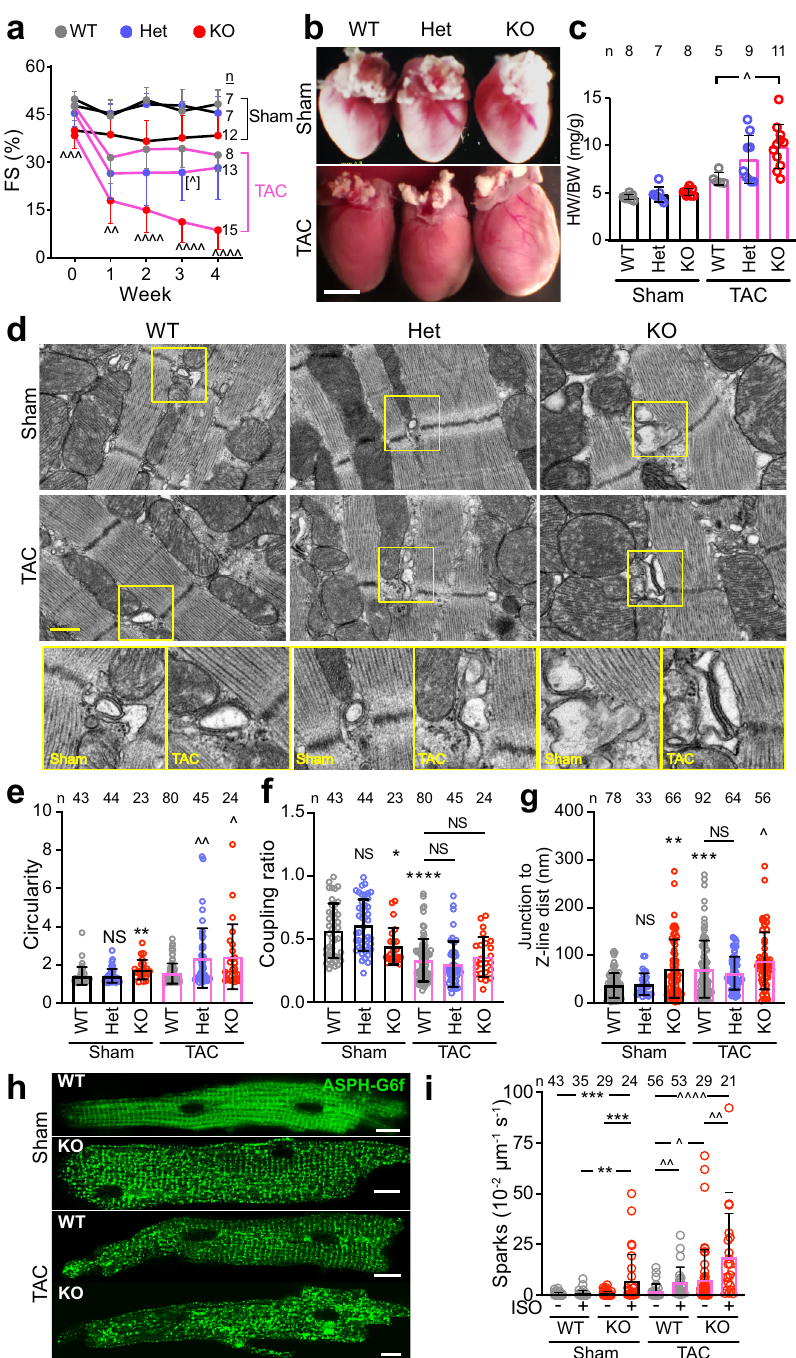
Fig. 5 CMYA5 protects the heart and dyads from the deleterious effects of pressure overload. Cmya5 KO and WT mice underwent baseline echocardiography (week 0) and then TAC or Sham surgery. After 4 weekly echocardiograms, necropsy was performed. a Systolic heart function. FS fractional shortening. Repeated-measures two-way ANOVA was performed for TAC cohort, with a comparison to WT-TAC ( ∧ ) at each time point. n , number of mice. b Gross cardiac morphology. Bar, 2.5mm. c Heart weight normalized to body weight. Kruskal-Wallis with Dunn ’ s multiple comparison test vs.WT within Sham (*) or TAC ( ∧ ) cohorts. n number of mice. d – g Dyad architecture analyzed by transmission electron microscopy. Boxed regions are magni fi ed in the bottom row. Bar, 500 nm. Quanti fi cation of T-tubule circularity, jSR-to-T-tubule coupling ratio, and Junction-Z-line distance. Kruskal – Wallis with Dunn ’ s multiple testing correction vs. WT Sham (*) or TAC ( ∧ ). n, number of dyads per group, from at least 10 cardiomyocytes from 3 different mice. h , i Cardiomyocytes were transduced with dyad-localized ASPH-G6f Ca 2 + nanosensor. Images of nanosensor distribution indicate dyad disorganization induced by TAC and Cmya5 KO ( h ). Quanti fi cation of Ca 2 + sparks by confocal line scan imaging of nanosensor. Kruskal – Wallis with Dunn ’ s multiple testing correction within Sham (*) or TAC ( ∧ ). n, number of cardiomyocytes per group. ∧ , P = 0.054; ∧ or *, P < 0.05; ∧∧ or **, P <0.01; ∧∧∧ or ***, P < 0.001; ∧∧∧∧ or ****, P < 0.0001. Two-sided statistical tests were used. Data are presented as mean